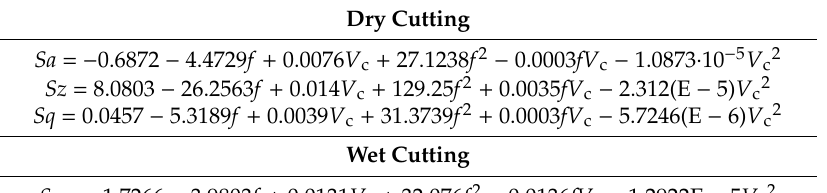
Table 2. Statistical models for Sa , Sz and Sq calculations after finish processing steel tested under different cooling conditions.